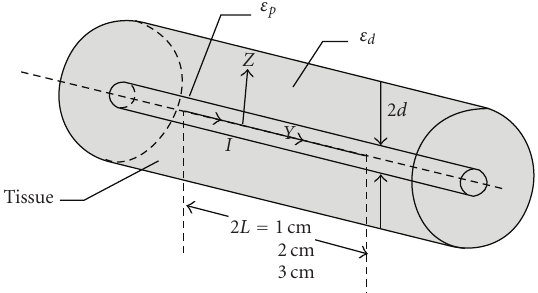
Figure 1: Model of antenna, dielectric insulation and dissipative